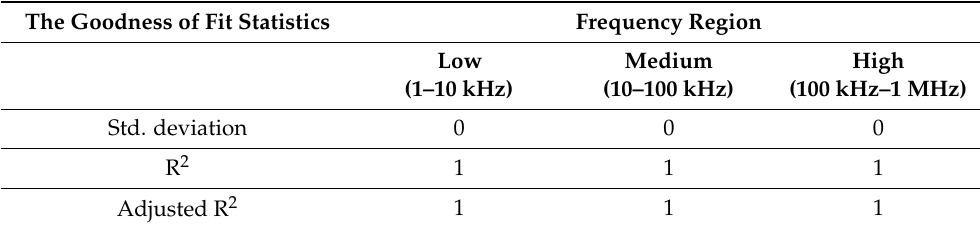
Table 4. Regression analysis for frequency regions in healthy winding conditions.